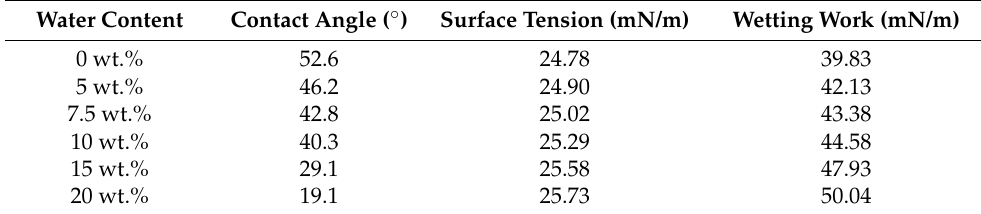
Table 2. Wetting work of polishing fluids with different water contents. Water Content Contact Angle ( ◦ ) Surface Tension (mN/m) Wetting Work